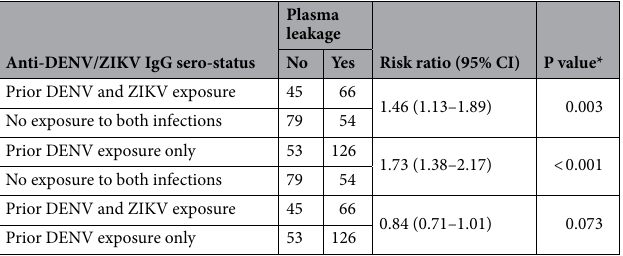
Table 2. Association between previous DENV / ZIKV exposure and plasma leakage during the current DENV infection. *Calculated as Pearson chi square 2-tailed p value.